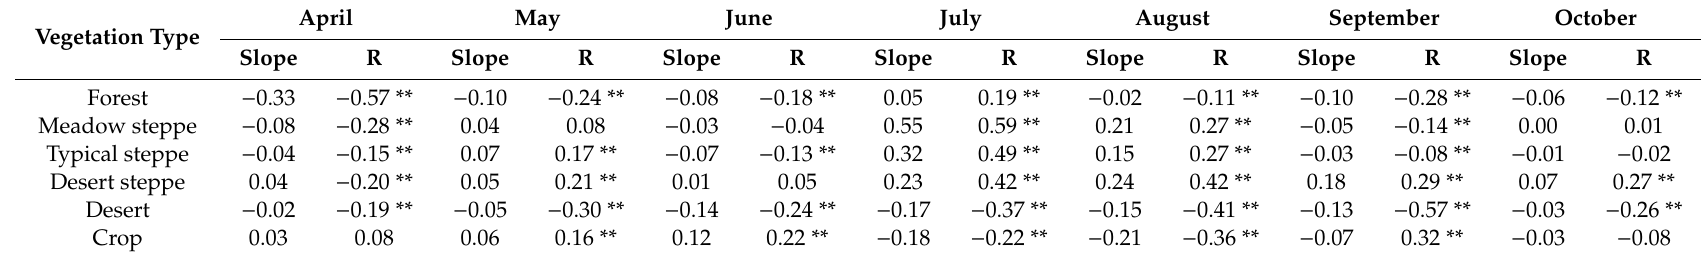
Table 2. Relationships between the CVs of monthly precipitation and those of the NDVI for di ff erent biomes in Inner Mongolia from 1982 to 2015. Vegetation